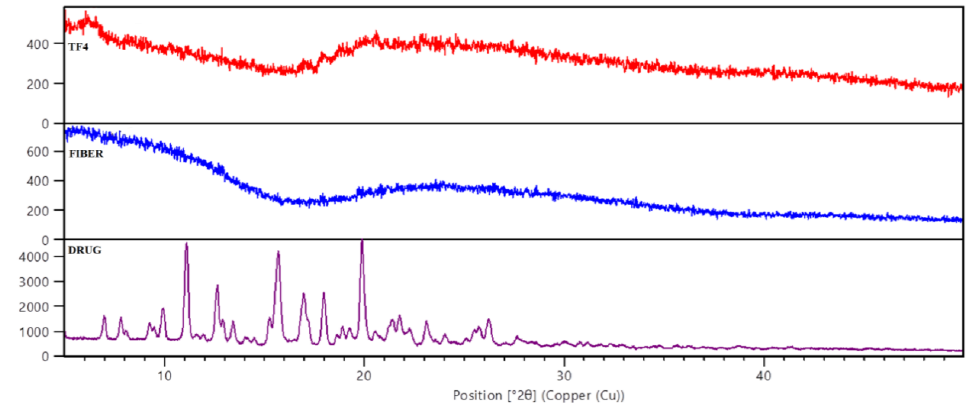
Figure 3. X-ray Diffraction pattern of drug, fibers, and transdermal films (TF4).